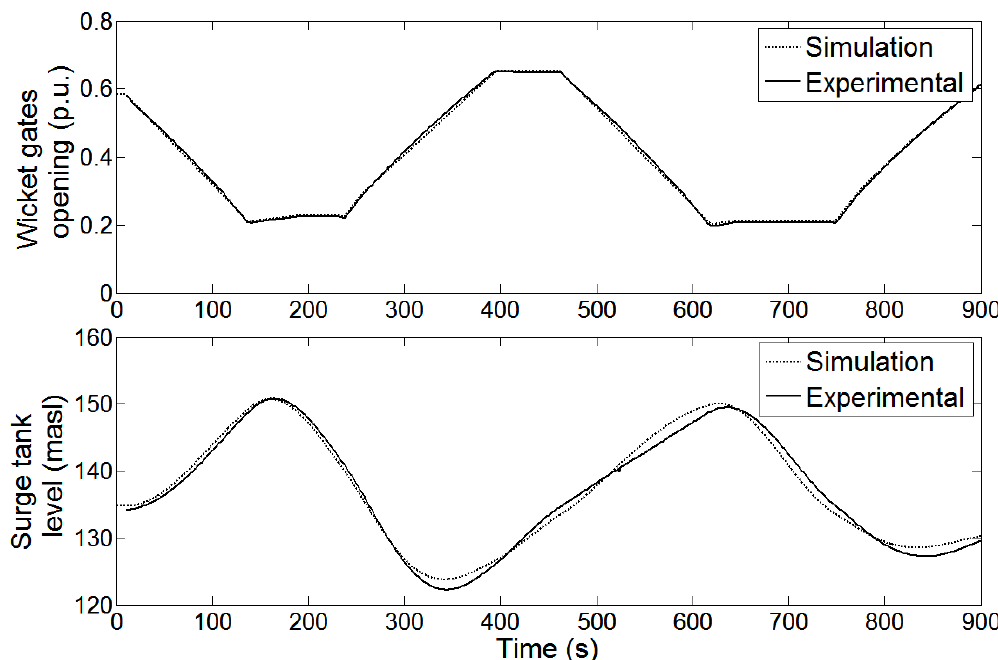
Figure 6. Comparison of recorded and simulated wicket gate opening and surge water tank level (on-site Test